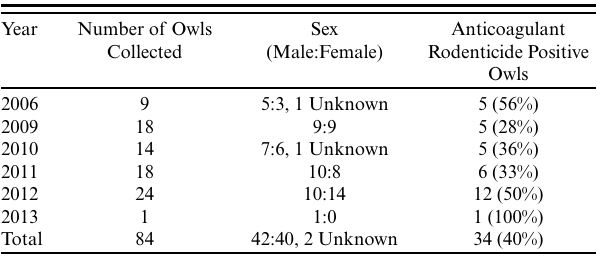
Table 2 . Results of Barred Owls ( Strix varia ) anticoagulant rodenticide exposure, year collected, and the sex of the individual from both Humboldt and Del Norte Counties in Northwestern California, USA.